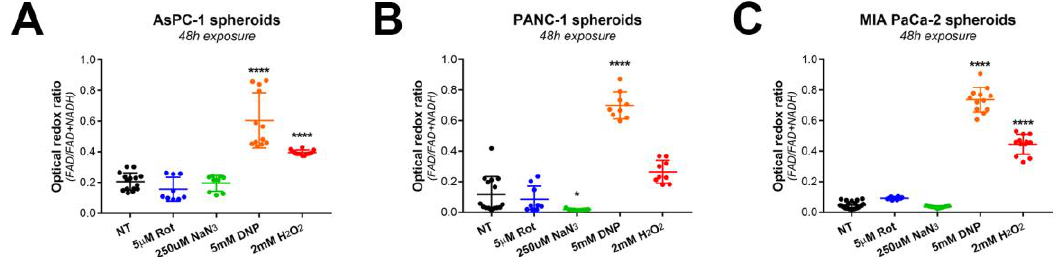
Figure 3. Proof of concept for the redox imaging workflow to detect ORR changes in pancreatic ductal adenocarcinoma (PDAC) spheroids under controlled conditions. Quantification of ORR in spheroids of AsPC-1 ( A ), PANC-1 ( B ), and MIA PaCa-2 ( C ) cell lines. Spheroids were either untreated (black), or imaged following 48-h exposure to 5 µM rotenone (blue), 250 µM sodium azide (NaN 3 ) (green), 5 mM 2,4-dinitrophenol (DNP; orange), or 2 mM H 2 O 2 (red). Black horizontal lines indicate the median optical redox ratio per group. Data were obtained from N = 6–9 samples from three experimental repeats. * p ≤ 0.05, **** p ≤ 0.001.